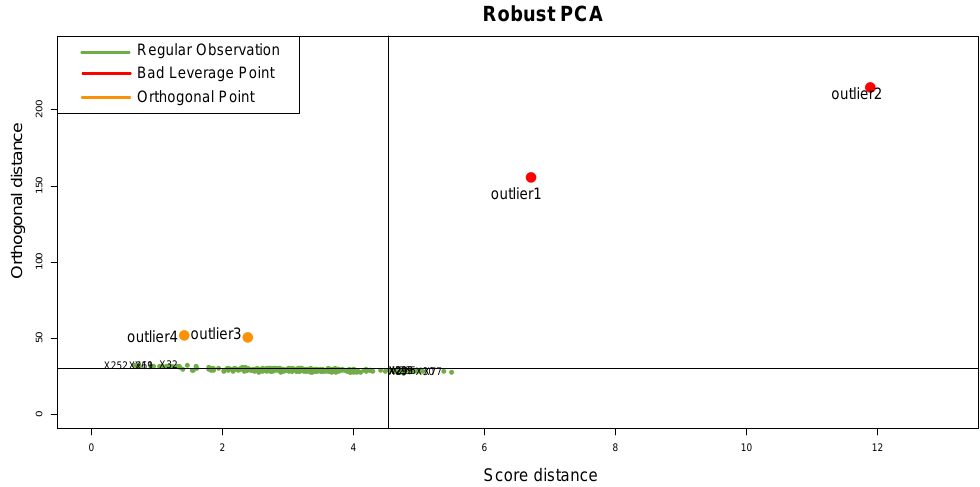
Figure 7. DD-plot of the second synthetic dataset. The two BLP s are in red in the top-right quadrant, and the two OO s are in orange in the top-left quadrant.